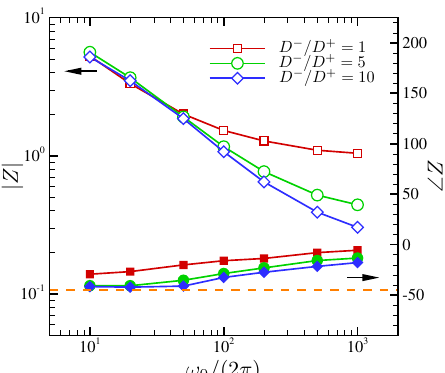
Figure 23. The Bode plot of the overall cell impedance Z . The horizontal dashed line corresponds to 45 ◦ . ∠ Z = −